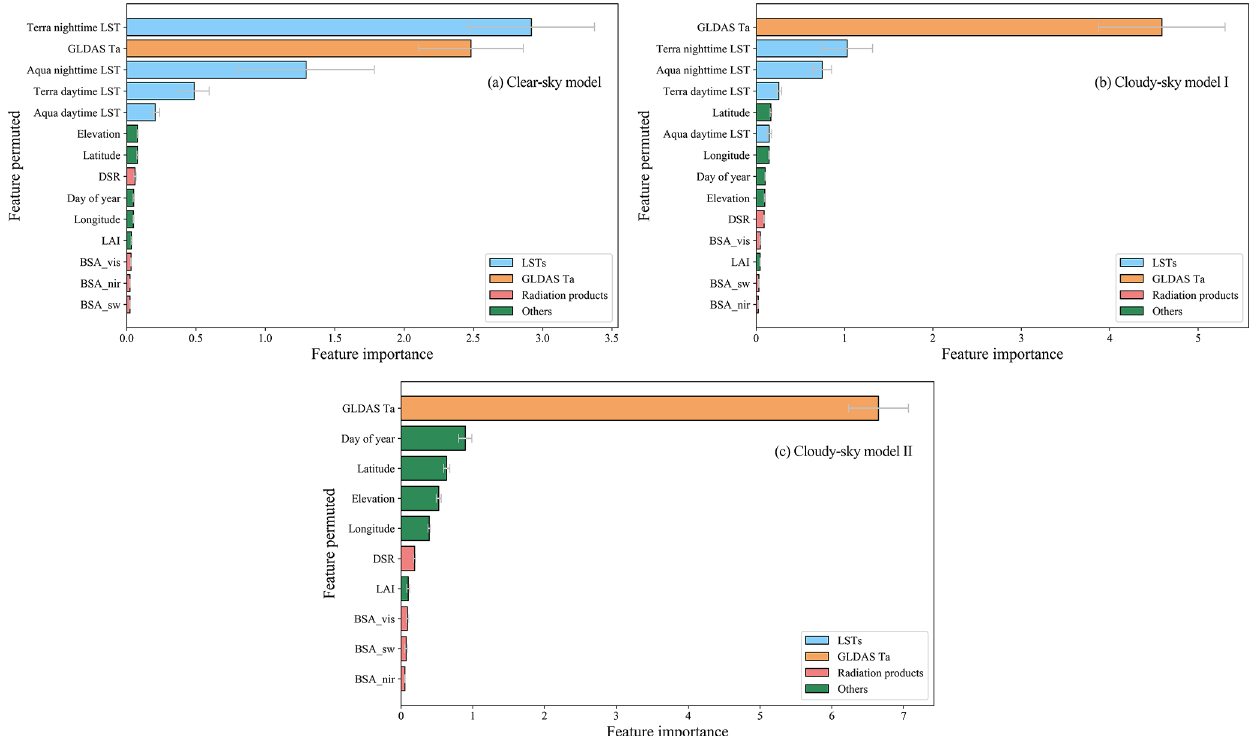
Figure 10. FI of each feature for three